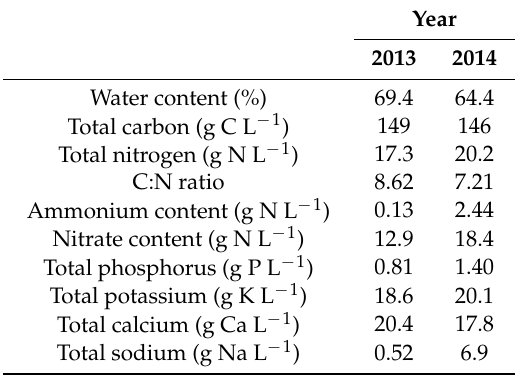
Table 2. Chemical characteristics of distilled silage